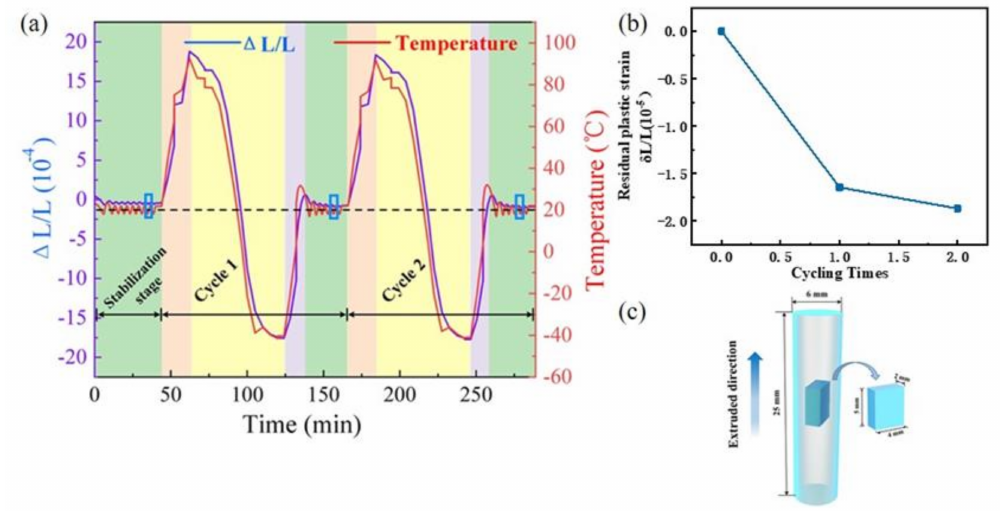
Figure 1. ( a ) The curves of the temperature and thermal strain along the extrusion direction during the thermal cycling test. ( b ) The curve of the residual plastic strain, which is calculated from the strain marked by the blue box in ( a ) and the number of thermal cycles. ( c ) Schematic diagram of the sampling direction of the EBSD